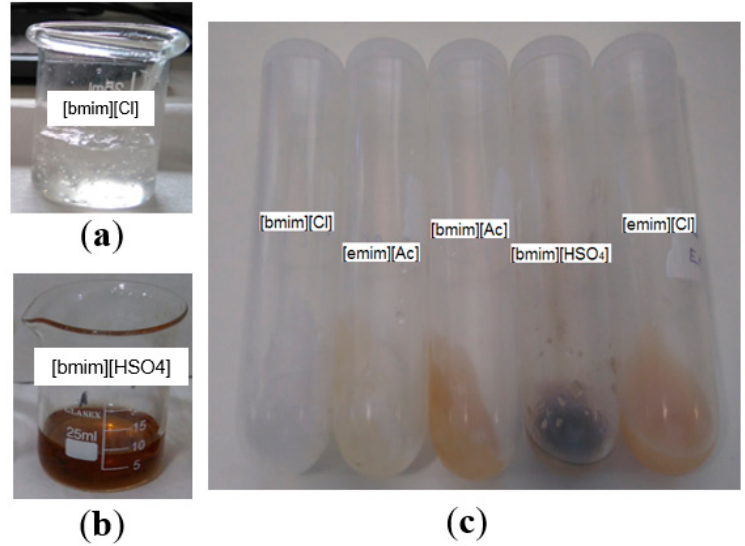
Figure 4. Cellulose pulp treated with ILs: ( a ) treated with [bmim][Cl] before washing; ( b ) pulp treated with [bmim][HSO 4 ] before washing; ( c ) pulp samples treated with the corresponding ILs after centrifugation and IL removal.